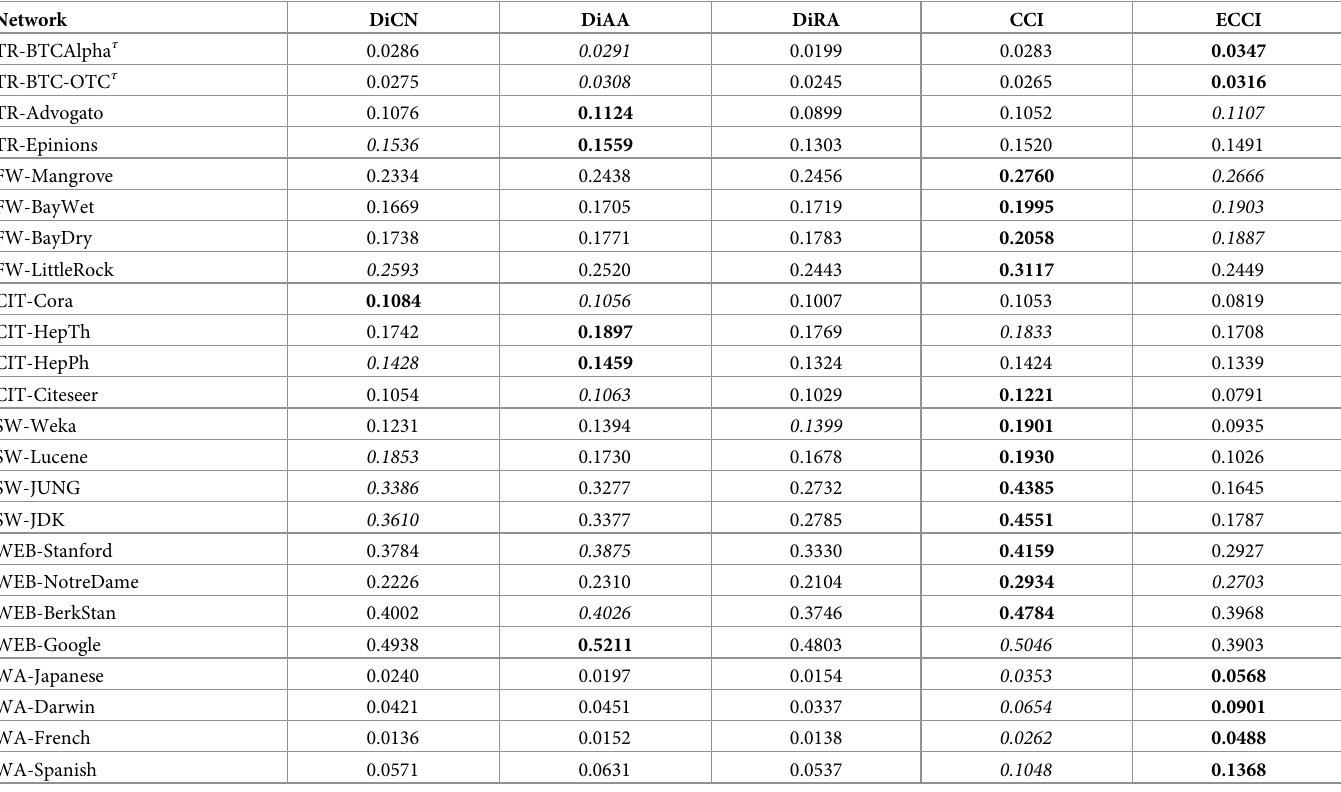
Table 3. Performance comparison of five methods on link prediction in directed networks (PR-AUC). The best performance in each network is in bold type, second best in italic.